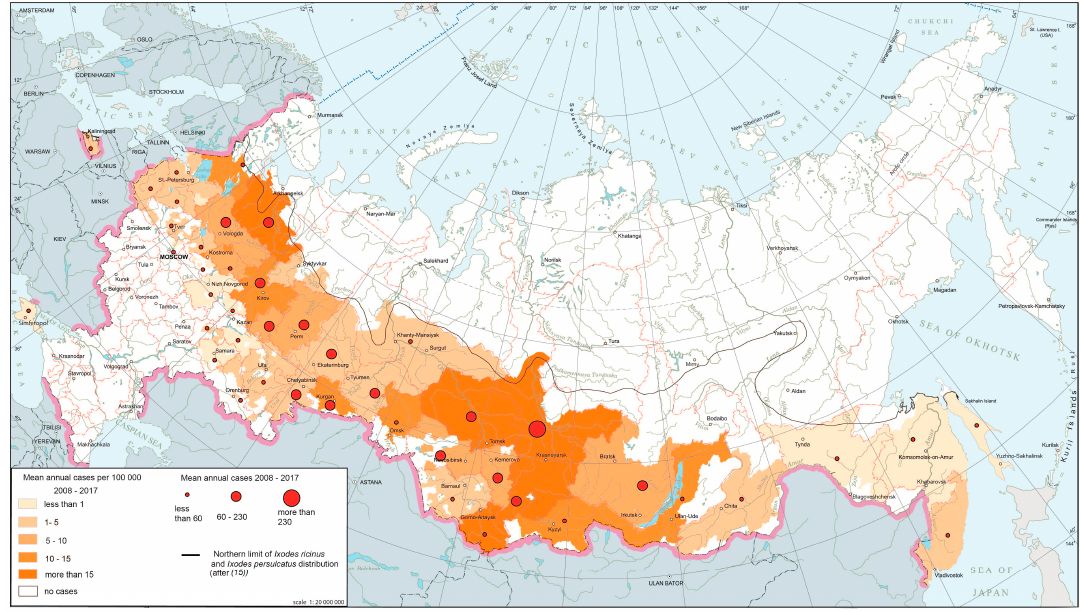
Figure 2. Tick-borne encephalitis morbidity in Russia,